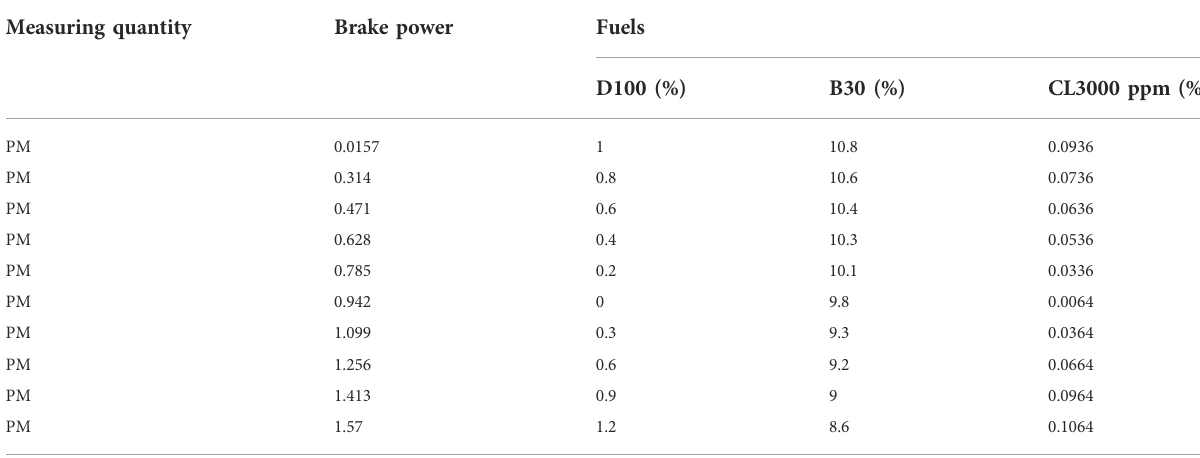
TABLE 7 Error reduction in particulate matter